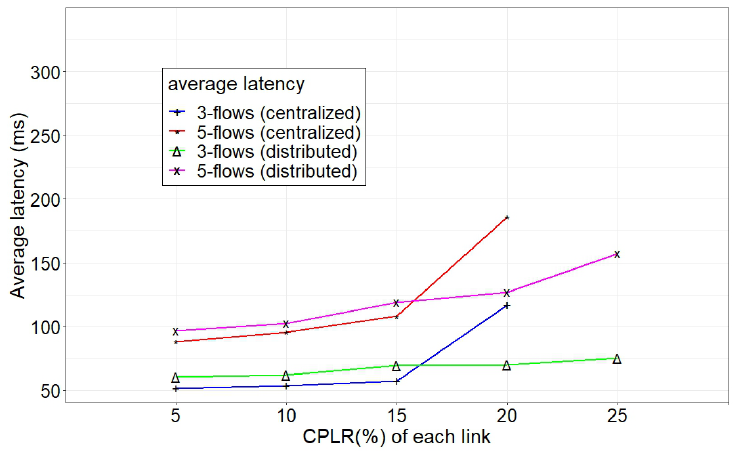
Figure 5. Data plane performance metric (average latency) comparison between centralized and distributed operations, during unreliable control plane conditions in a 9-node grid network.